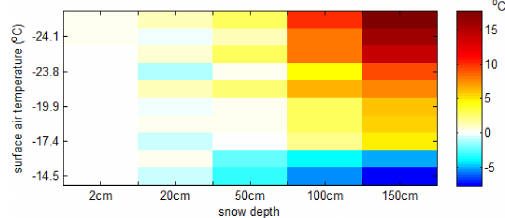
Figure B2. Model error when the linear snow correction model is used to predict temperatures at snow-depth or snow–ground inter- face for data from Morse and Burn (2010) (measurement data are down snow column temperatures). Positive numbers indicate that the linear model output is too warm compared to